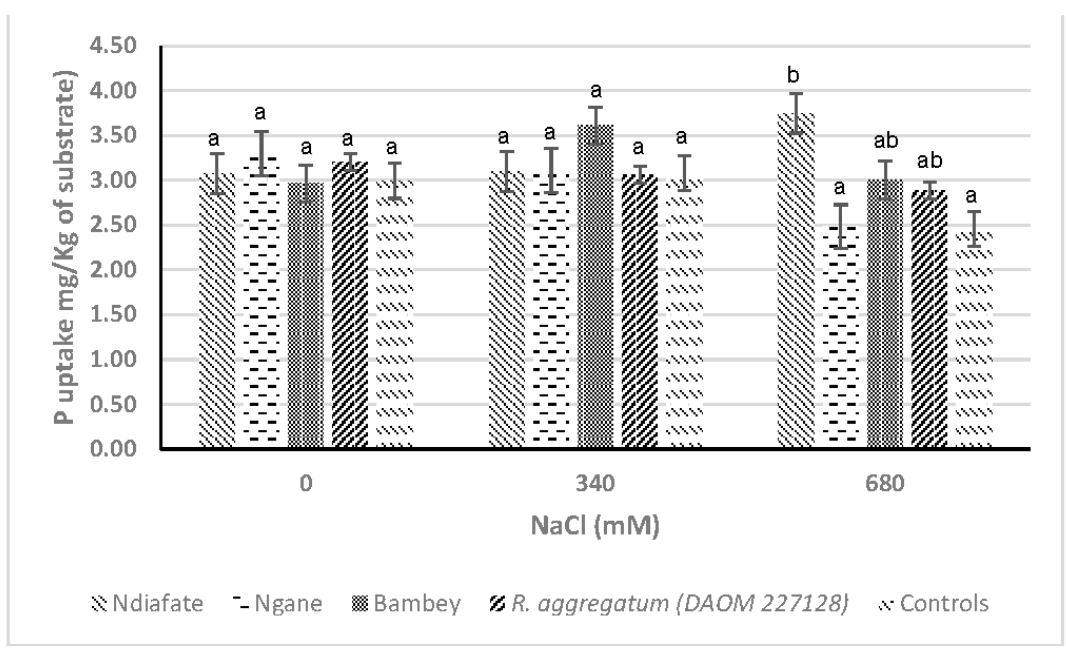
Figure 5. The effect of the AMF isolates × NaCl interaction on the dry root biomass of A. seyal seedlings after 30 days of culture. Ndiafate, Ngane, and Bambey correspond to high, moderate, and low salinity zones, respectively where the AMF were collected. Bars with the same letters for each variable are not significantly different at p < 0.05 (Newman–Keuls test) and error bars represent standard error of the mean ( n = 270).